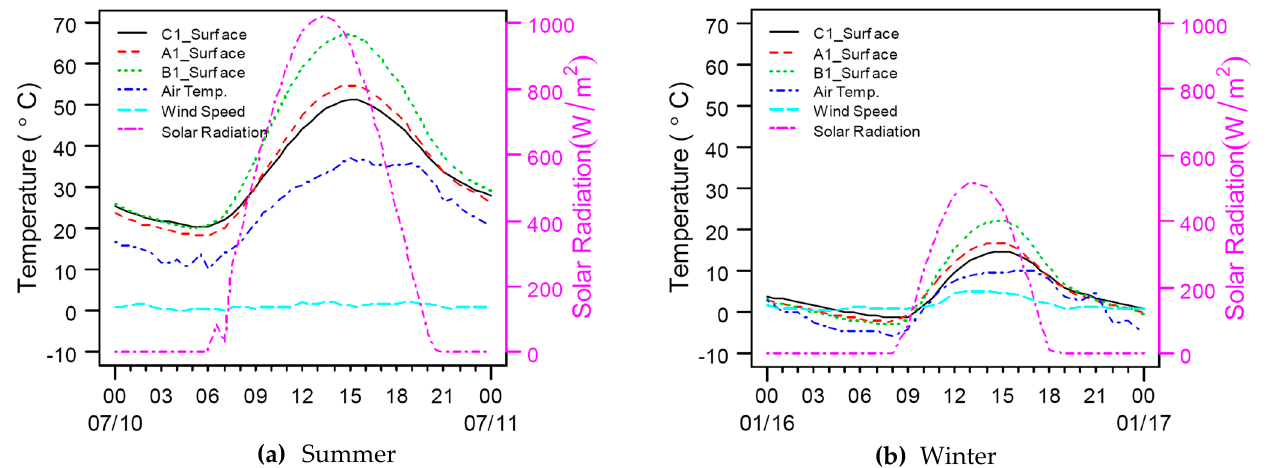
Figure 9. Daily variations of ground surface temperature for different pavements (A1 = Paver, B1 = Asphalt, C1 = Concrete) in summer ( a ) and in winter ( b ). Air temperature, wind speed, and solar radiation are also displayed [30].